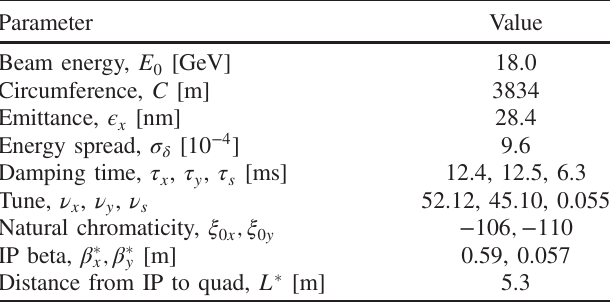
TABLE I. Main parameters of the electron storage ring.